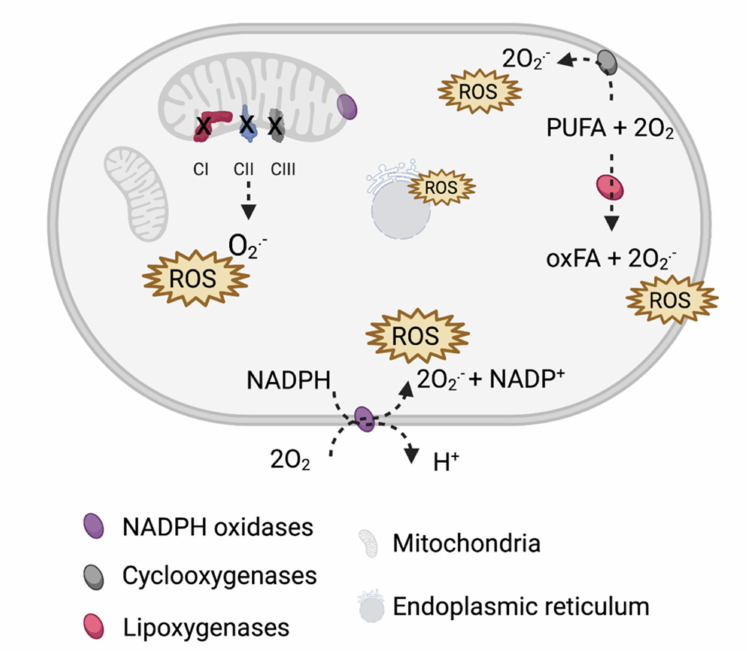
Figure 1. Main sources of reactive oxygen species (ROS) in cells. ROS are primarily generated by electron leaks from mitochondrial complexes I–III (CI–CIII) and ROS-producing enzymes: NADPH oxidases, cyclooxygenases, and lipoxygenases that catalyze the oxygenation of polyunsaturated fatty acids (PUFA). Additionally, protein oxidation on the endoplasmic reticulum (ER) and ER-related stress add to the ROS